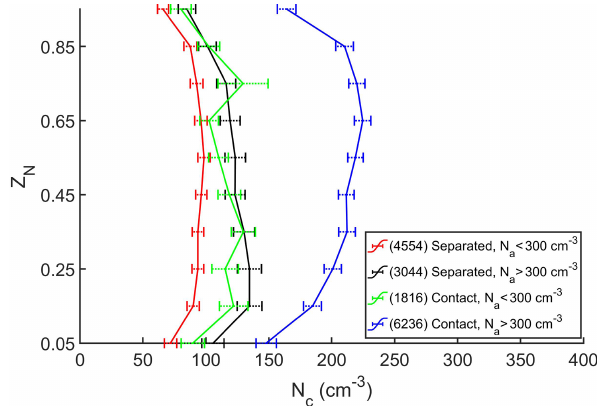
Figure 18. Mean cloud droplet number concentration ( N c ) as a function of normalized cloud depth ( Z N ), where the mean is com- puted for 397 vertical profiles flown during the three ORACLES campaigns. Different colors correspond to whether the bound- ary layer below cloud has average aerosol concentration N a < 250cm − 3 or N a > 250cm − 3 as measured by PCASP and accord- ing to whether a layer of BB aerosol is in contact with ( N a > 500cm − 3 within 100m of cloud top) or separated from cloud top (no layer with N a > 500cm − 3 within 100m of cloud top). Uncer- tainties indicated by horizontal error bars represent the 95% con- fidence intervals. Numbers in parentheses represent the number of 1s data points included in each of the profiles. See text for details.